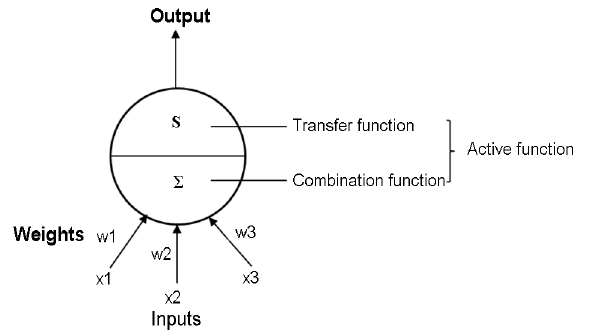
Fig. 2. Typical processing unit in neural network (Tso, Yau 2007)